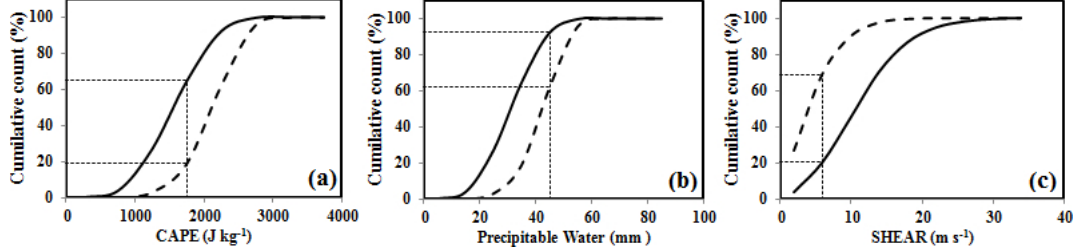
Fig. 6. Cumulative frequency distribution of (a) CAPE; (b) PW and; (c) SHEAR for the time period 2000–2011. The thick solid line is for the northern sites and the thick dashed line is for the southern sites. Table 4. Fraction of mercury mass (%) transported from an initial altitude to a final altitude by the passage of a thunderstorm. Transport includes advection and within precipitation. Each column corresponds to an experiment initialized with 30pgm − 3 GOM and HgP in the specified initial altitude range and zero elsewhere. The STD experiment has uniform 30pgm − 3 initial mixing ratios through the entire column. The total mass of mercury in each experiment is 71.3ngm − 2 (PBL), 98.8ngm − 2 (LFT), 148ngm − 2 (UFT), 191ngm − 2